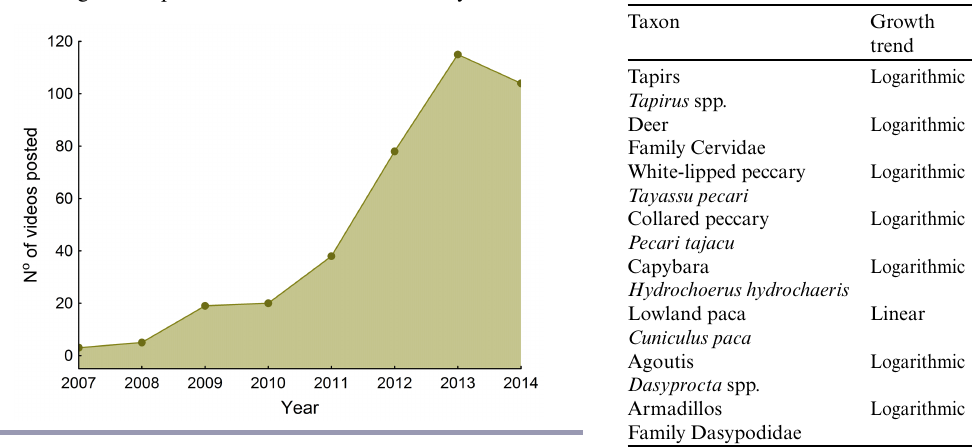
Table 2 . Growth trend of the accumulation curves of hunting videos targeting the main hunted mammalian taxa in Brazil.